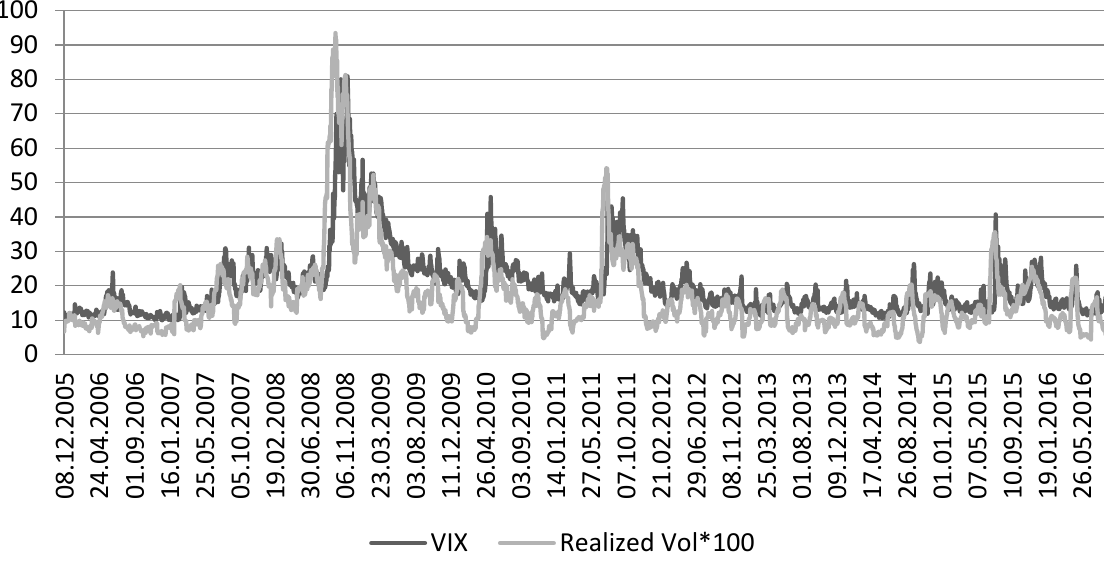
Figure 2. Evolution of implied volatility VIX and one month realized